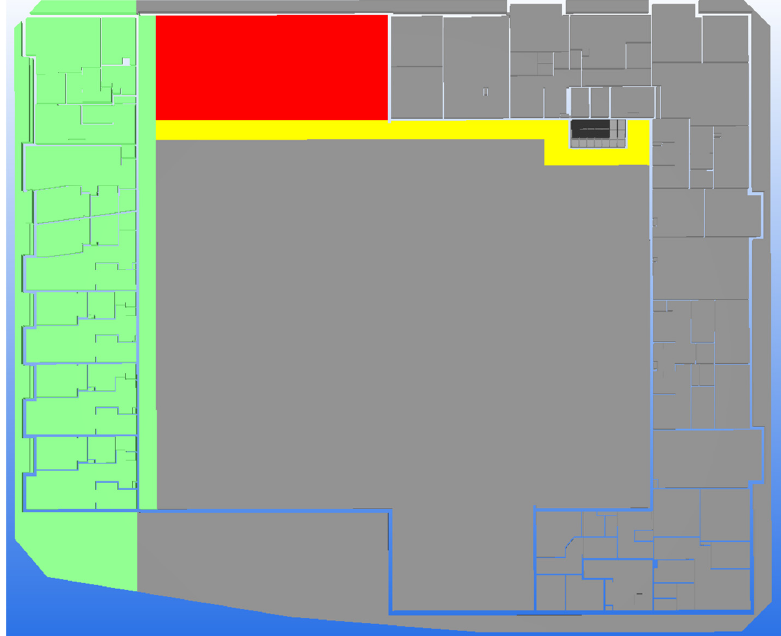
Figure 13. IFC spaces model of Plan 15 (corresponding to Figure 8), defining 3D property boundaries both inside and outside the building. The green areas for Bryggan 1 and the grey areas for Bryggan 2 including red areas (the use of easements) and yellow areas (easements for evacuation route).